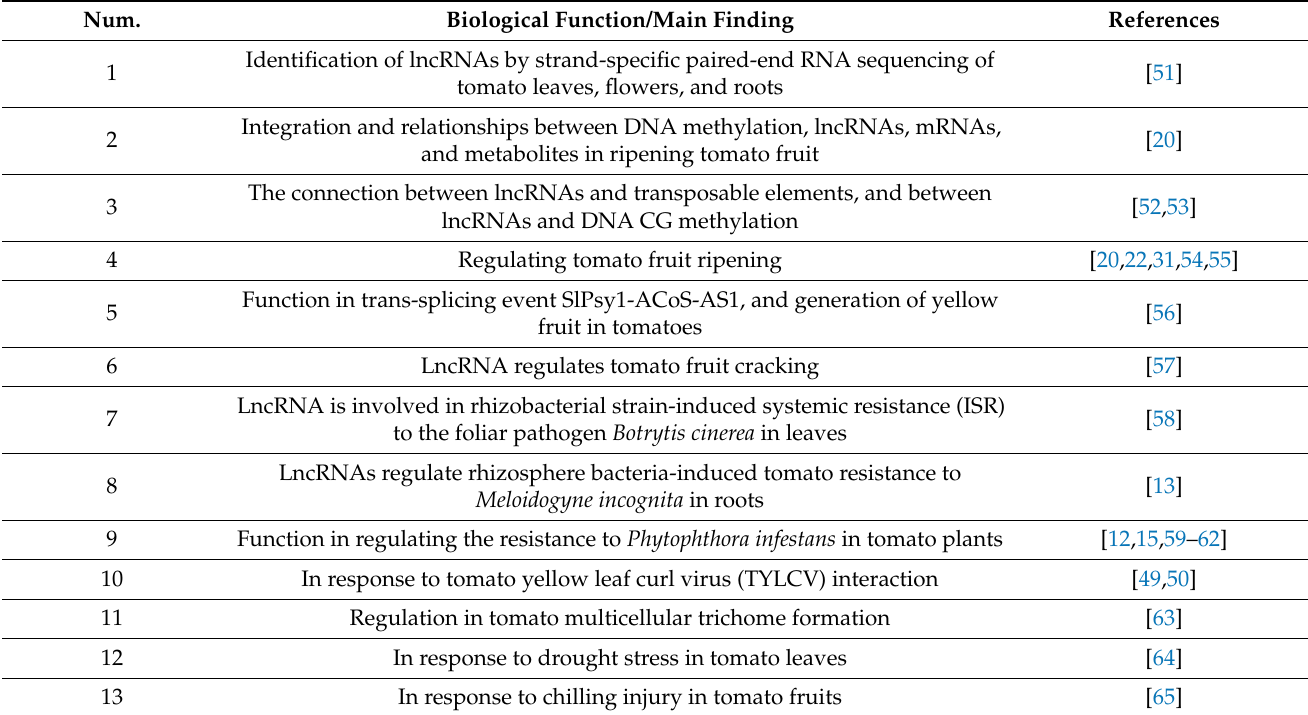
Table 1. Summary of progress of lncRNAs on tomato plants and fruits. Num.